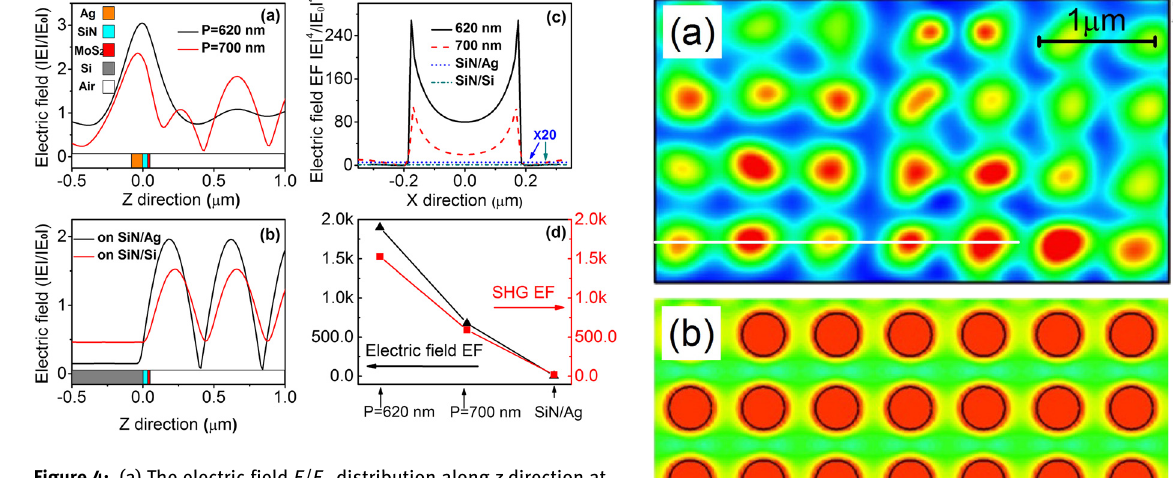
distributions along x 0 (red square) SiN / Si